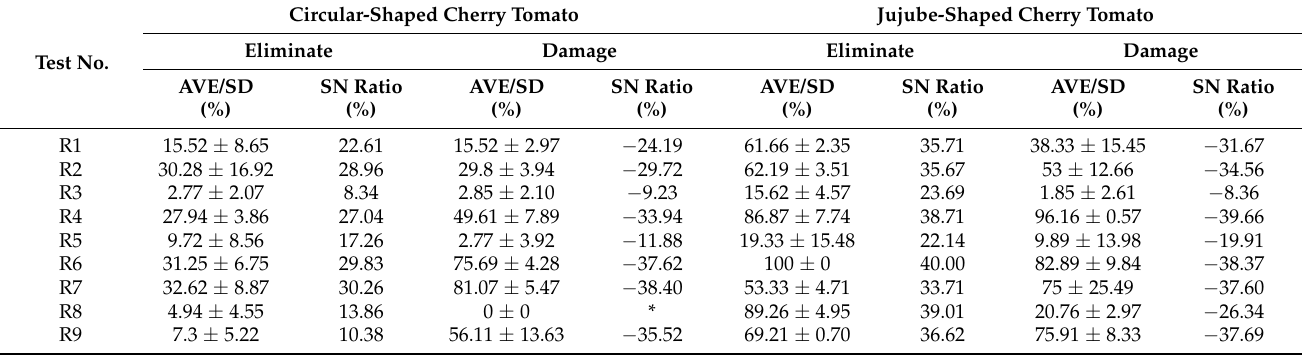
Table 4. Mean ratio (eliminate and damage) and S/N ratios (eliminate and damage) to remove calyx using the Taguchi method.